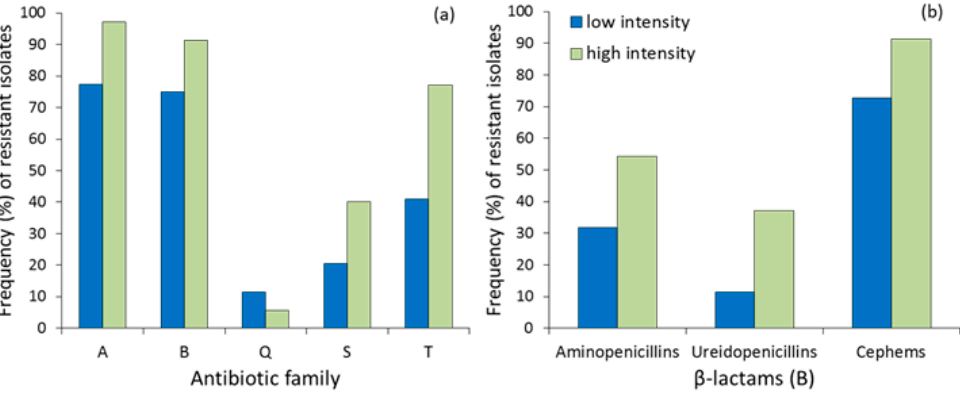
Figure 1. ( a ) Frequency (%) of resistant E. coli isolates to each antibiotic family (A = aminoglycosides, Figure 1.(a) Frequency (%) of resistant E. coli isolates to each antibiotic family (A= aminoglycosides, B B = β -lactams, Q = quinolones, S = sulfonamides, T = tetracyclines) and ( b ) subfamily of β -lactams in = β -lactams, Q = quinolones, S= sulfonamides, T = tetracyclines) and (b) subfamily of β -lactams in red red kite droppings from low- and high-intensity farming areas in Central kite droppings from low- and high-intensity farming areas in Central Spain.